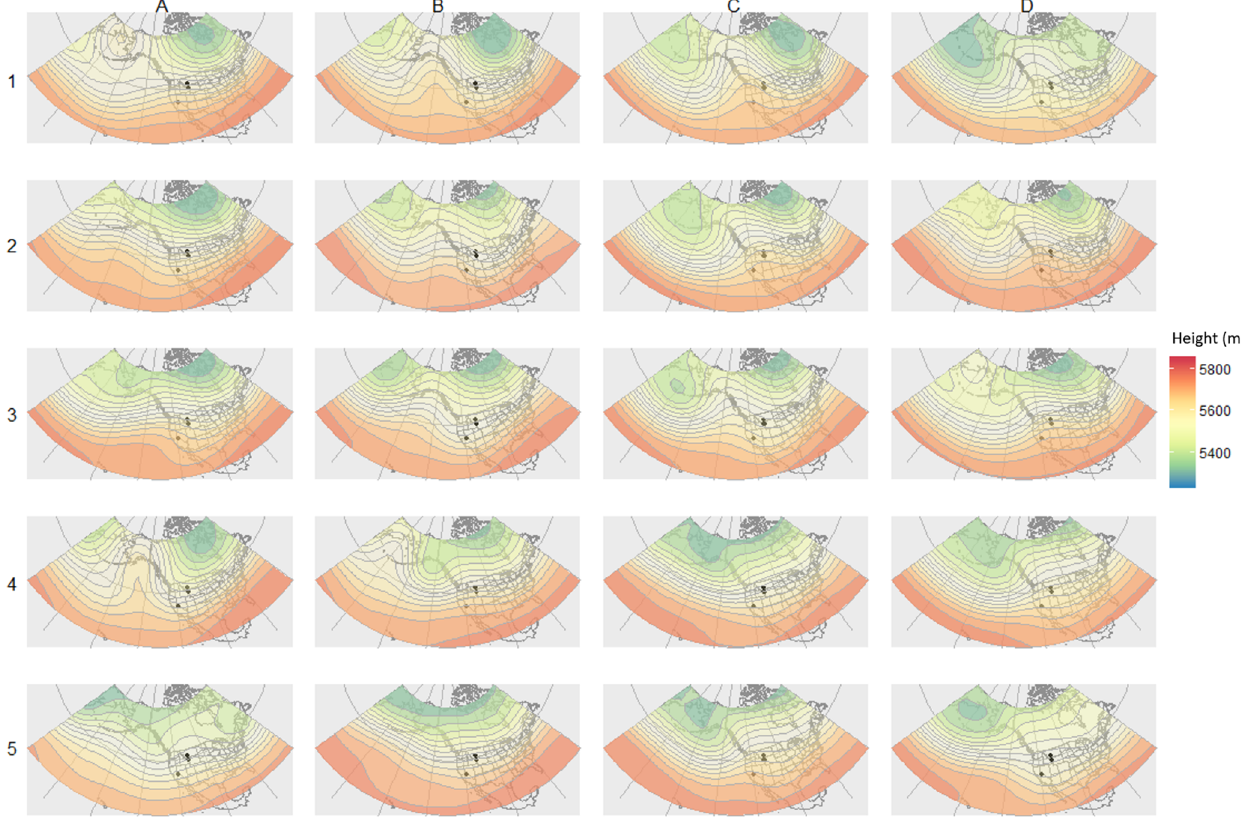
Figure 2. Array of 500mbar geopotential height map patterns generated using self-organizing maps. Each map pattern, or synoptic type, is a generalization of a group of days exhibiting a similar circulation